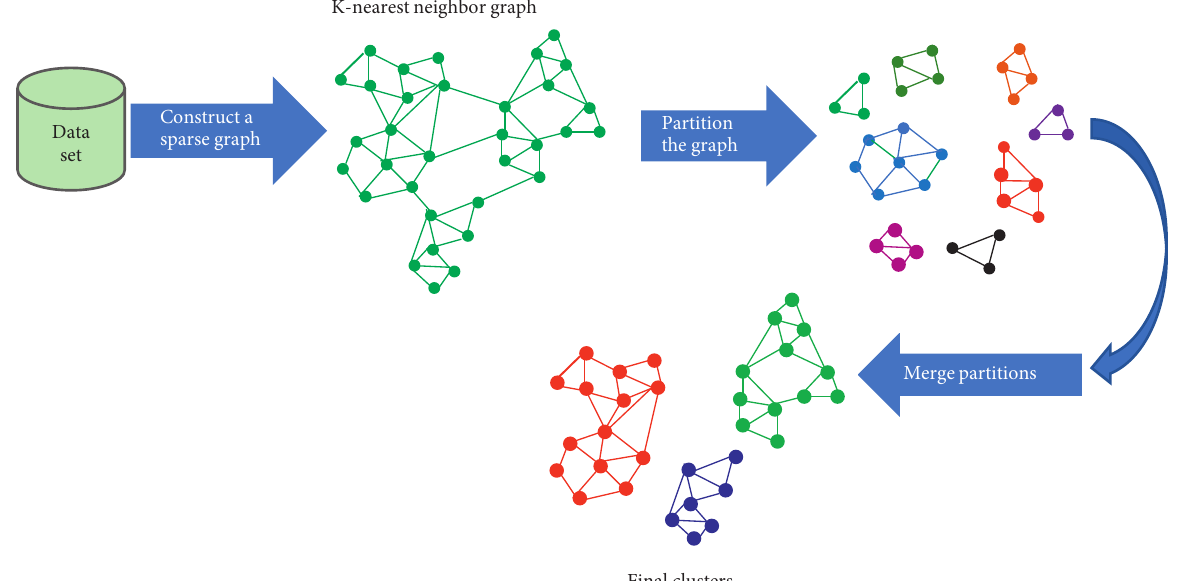
Figure 5: The main approach of